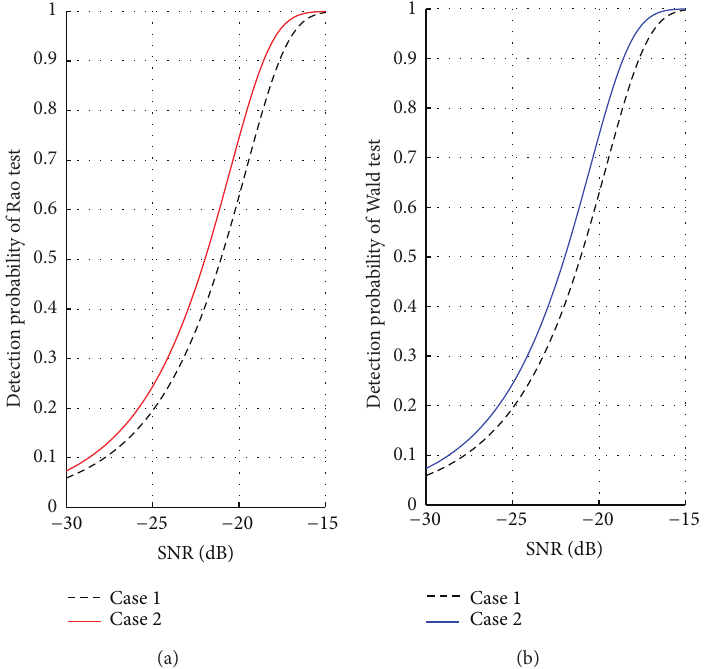
Figure 7: Performance comparisons of Rao test and Wald test between different